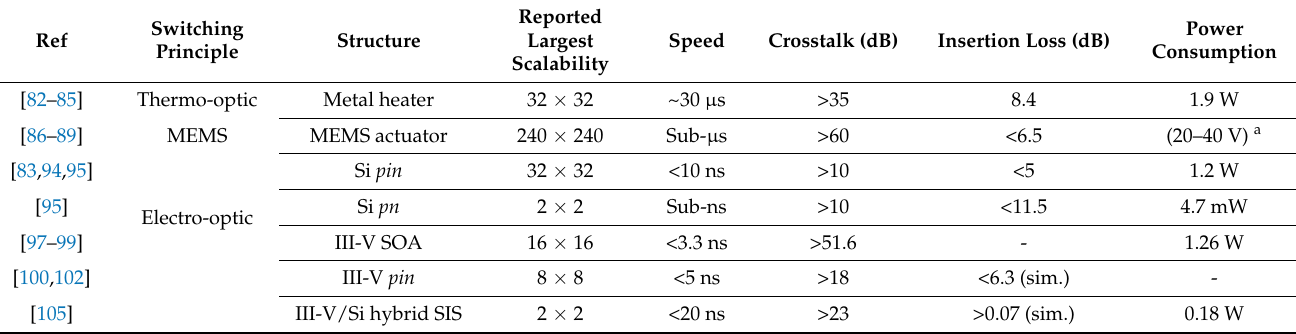
Table 2. Comparison of various integrated optical switches and their characteristics.